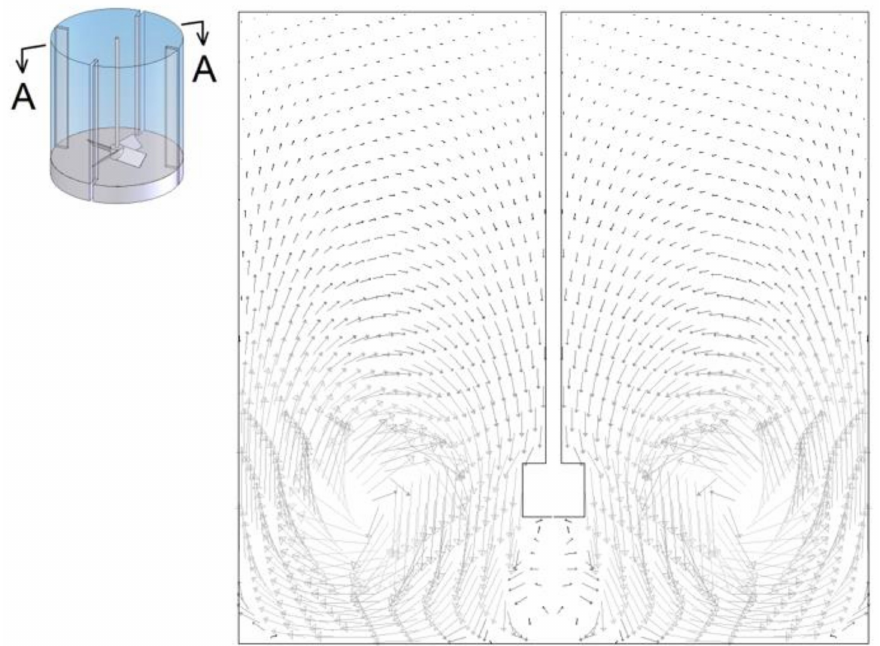
Figure 4. Velocity field in the A-A middle plane.